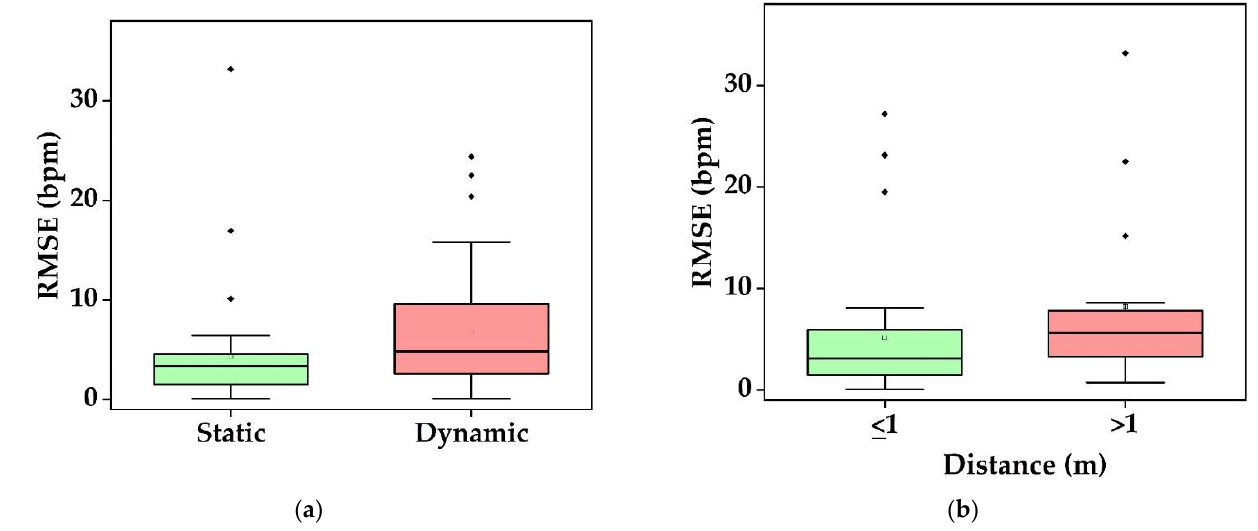
Figure 9. ( a ) RMSE of HR in static and dynamic conditions and, ( b ) varying distance between the subject and camera.